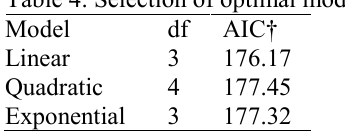
Table 4. Selection of optimal